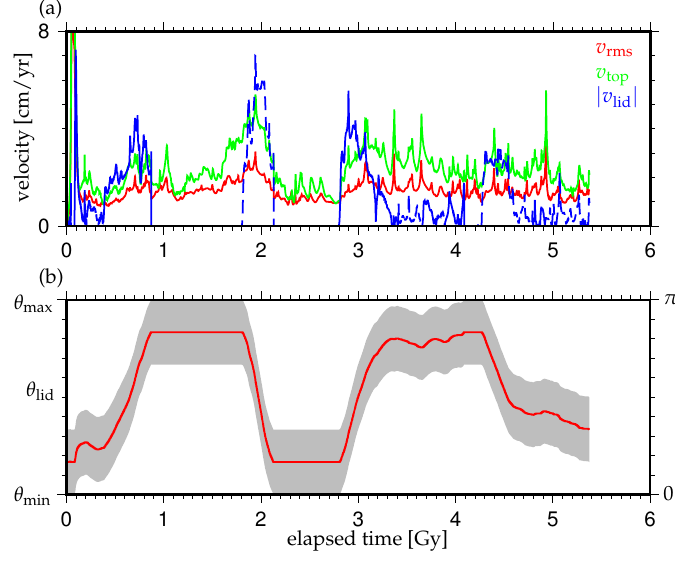
Figure 5. Same as Figure 3, but for Case